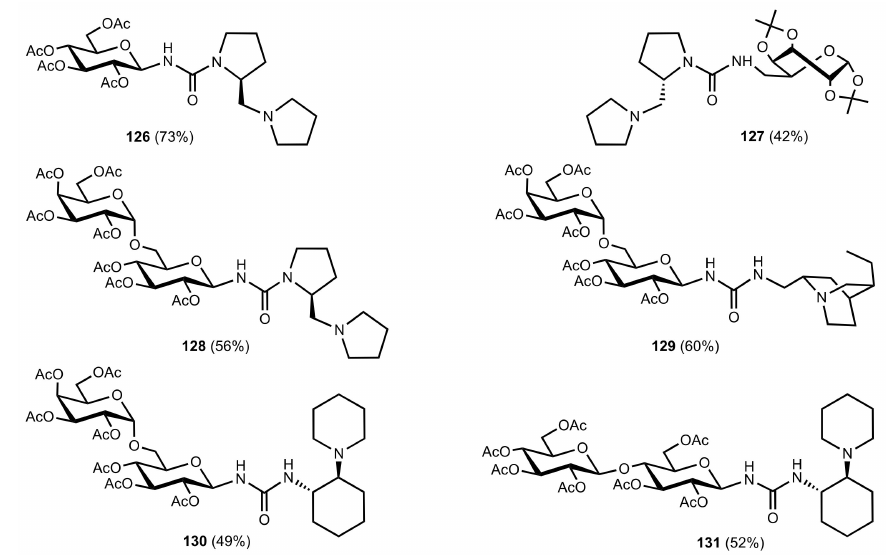
Figure 15. The structure of organocatalysts 126–131